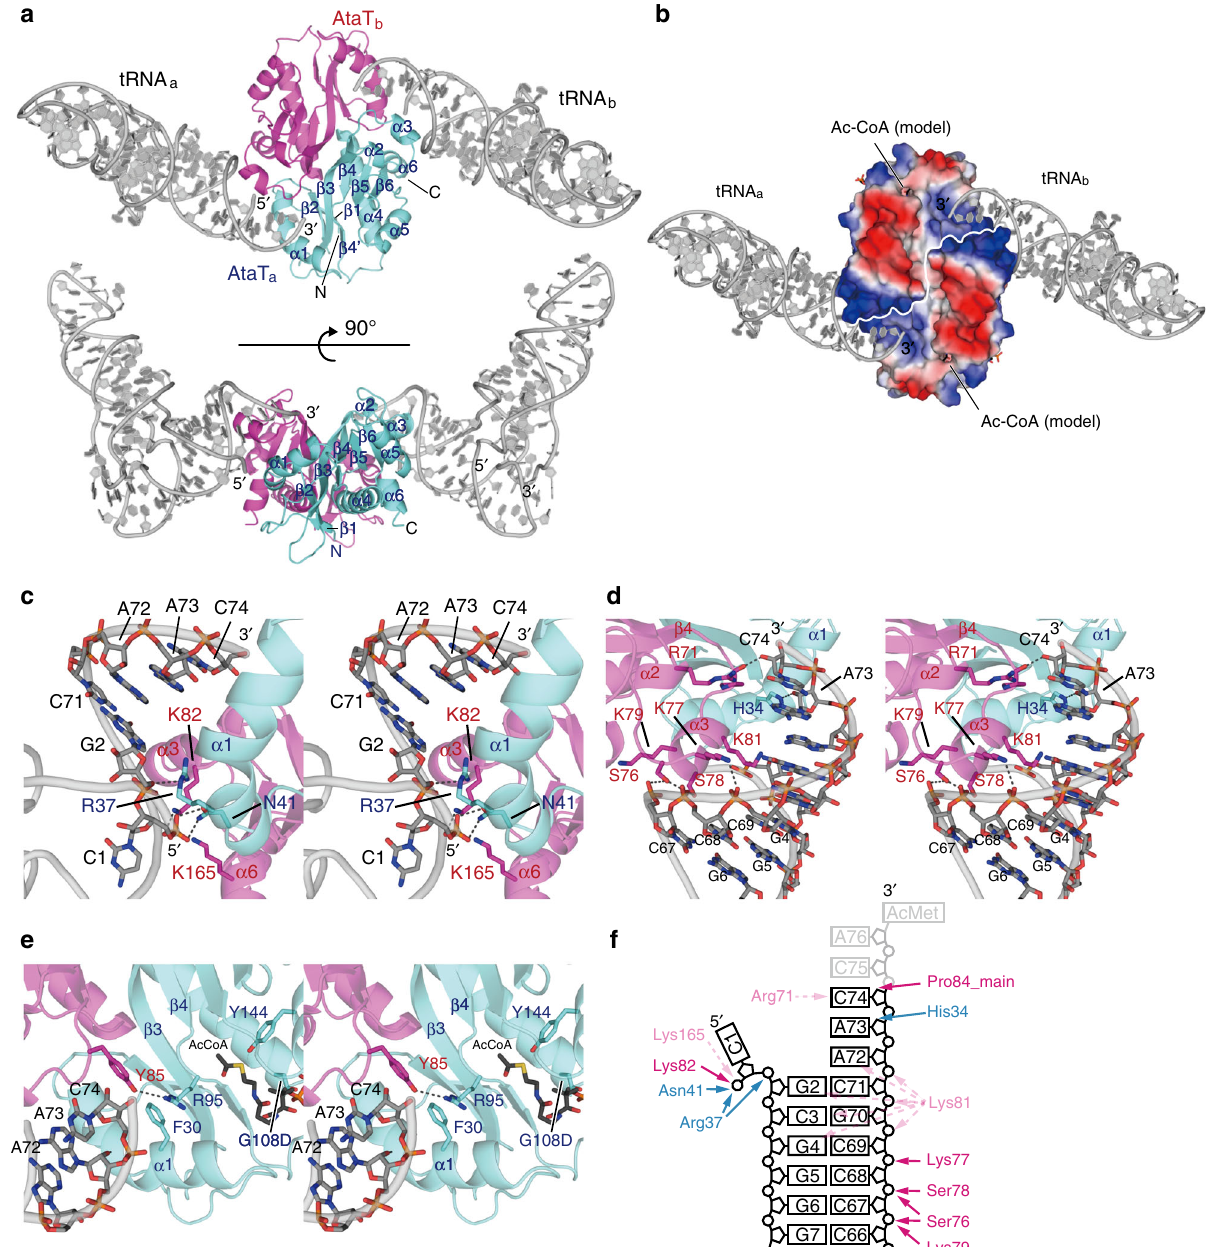
Fig. 2 Structure of AtaT complexed with Ac – Met – tRNAf Met . a Overall structure of AtaT complexed with acetyl – Met – tRNAf Met (Ac – Met – tRNAf Met ). The ribbon models of the AtaTa, AtaTb, and Ac – Met – tRNAf Met molecules (tRNAa and tRNAb) are colored cyan, magenta, and gray, respectively. b Electrostatic surface area potentials of the AtaT dimer in the complex with Ac – Met – tRNAf Met . Positively and negatively charged areas are colored blue and red, respectively. Acetyl-CoA was modeled in the active site of AtaT. c – e Stereoviews of detailed interactions between AtaT and Ac – Met – tRNAf Met . AtaTa and AtaTb are colored as in a . tRNAf Met is shown as a gray stick model. Acetyl-CoA was modeled in the active site of AtaT in e as a black stick model. f Schematic representation of the interactions between AtaT and Ac – Met – tRNAf Met . Residues in AtaTa and AtaTb are colored cyan and magenta, respectively, as in a . All structural fi gures were prepared using PyMol respectively 20,21 . The loop between α 3 and β 4 in AtaTb and α 1 in acceptor helix. K81 in α 3 is positioned so its side chain can AtaTa form the path for the 3 ′ -end of tRNA to enter the catalytic interact with the phosphate backbones and nucleobases of site and interact with the 3 ′ -single-stranded region of tRNAf Met consecutive G – C pairs, at the top-half of the acceptor helix (Fig. 2d). The ribose 2 ′ -OH groups of C74 and A73 in tRNAf Met (Fig. 2d, f). Although an in vitro analysis demonstrated the interact with the main-chain carbonyl oxygens of P84 in AtaTb importance of the (G4G5G6:C67C68C69) sequence at the bottom and H34 in AtaTa, respectively, and the O2 atom of the C74 half of the acceptor helix (Fig. 1d, e), no base-speci fi c interactions nucleobase of tRNAf Met interacts with R71 in AtaTb. Residues were observed in the present structure, as described below. S76, K77, S78, and K79 in α 3 of AtaTb interact with the The 3 ′ -C75A76 – Ac – Met region of Ac – Met – tRNAf Met was disordered and not visible in the present structure. Y85 in the phosphate backbones of C67C68C69, at the bottom half of the